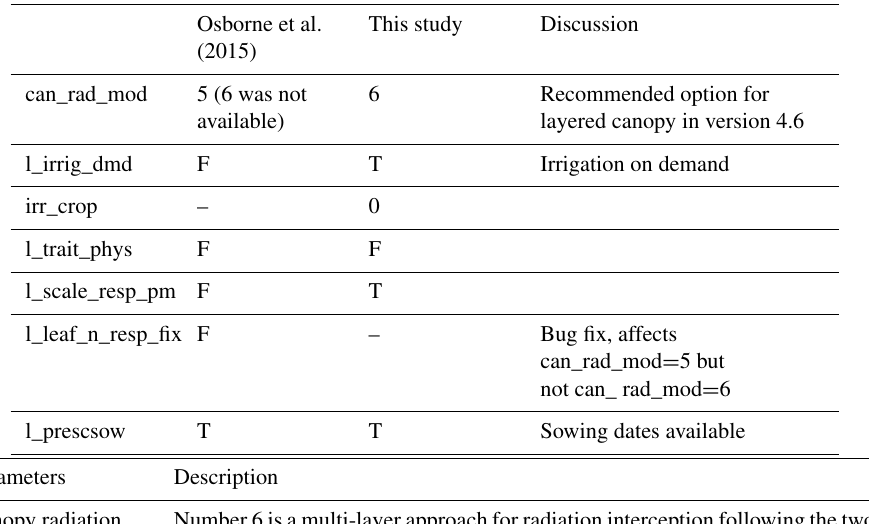
Table 1. JULES module switches, in which F (false) means turned off and T (true) means turned on.